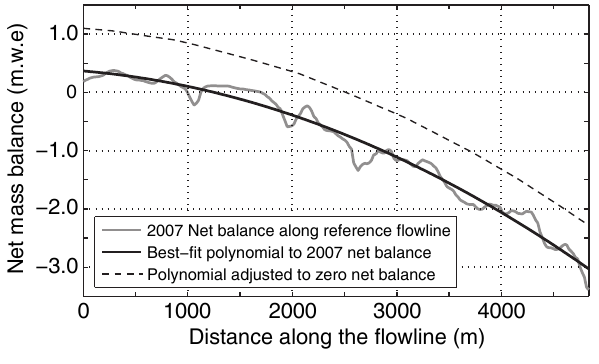
Fig. 3. Profile of the 2007 net surface mass balance along the ref- erence flowline (grey), best-fit polynomial (black) and best-fit poly- nomial adjusted to zero net balance (dashed). Alternative mass bal- ance forcings are achieved by shifting the curves up or